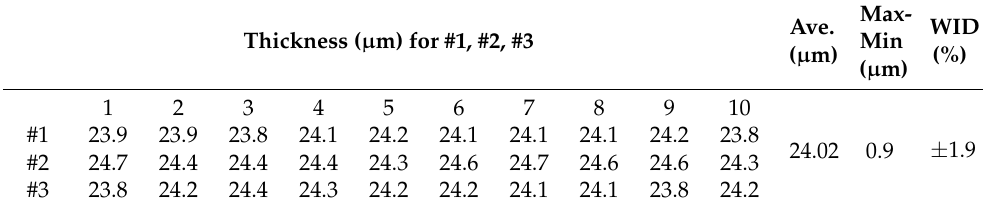
Table 10. WIW for #1, #2, and #3.